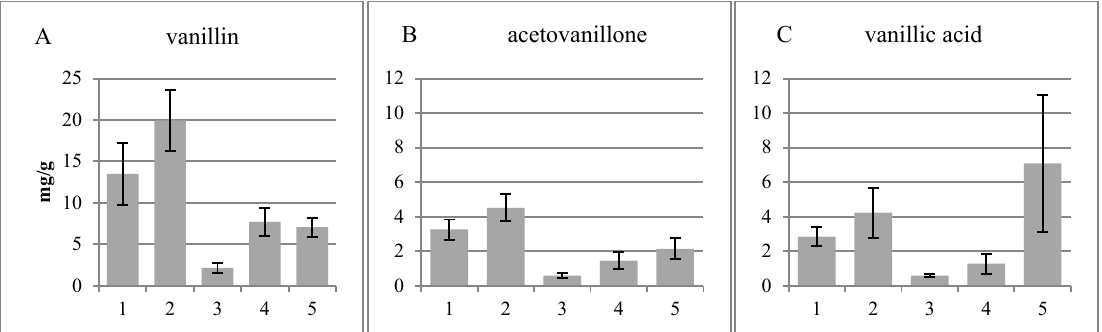
Figure 1. Photomicrographs of the silver birch sample sections with a cryomicrotome. ( A ) A cross-section through the stem. Mainly cellulosic cell walls are stained blue with Alcian blue and lignified tissues red with safranin. ( B ) Longitudinal sections presenting the actual samples for lignin analyses: 1, cork cambium; 2, non-conductive phloem; 3, combined conductive phloem, cambium and differentiating xylem; 4, lignified xylem; 5, previous year’s